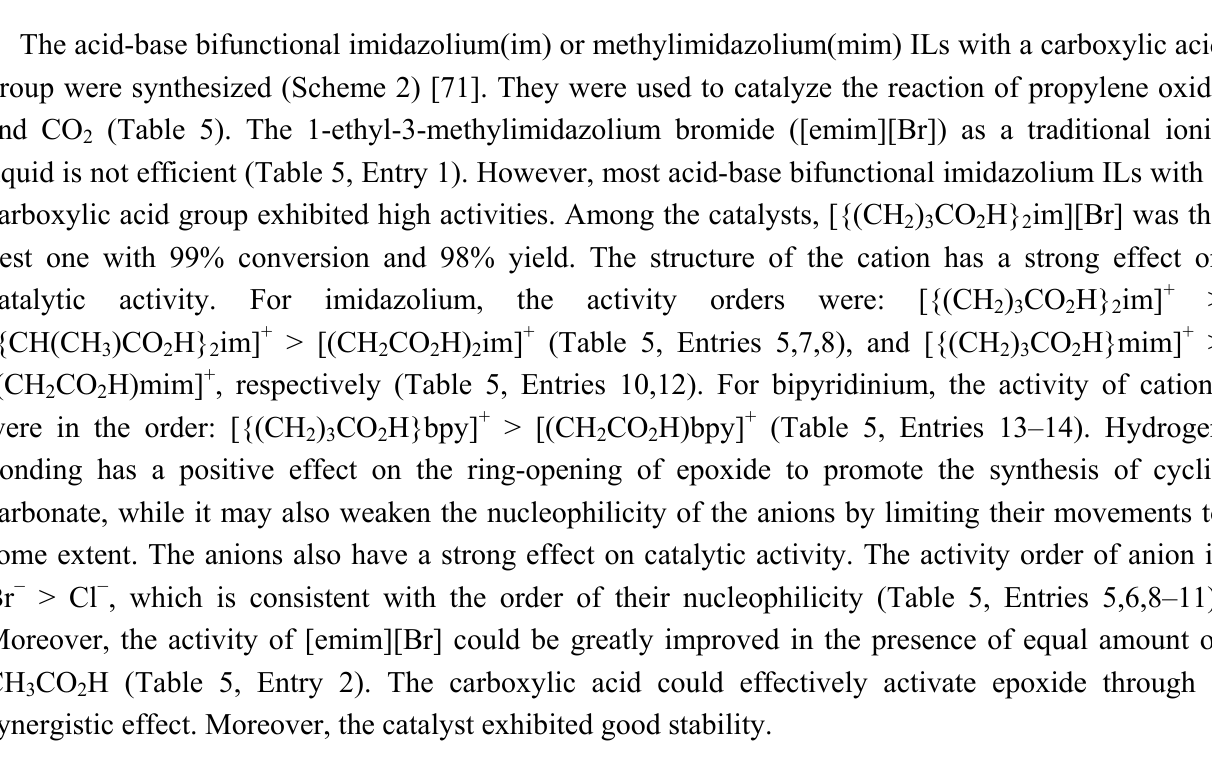
Table 5. Synthesis of PC catalyzed by acid-base bifunctional catalysts catalyst a